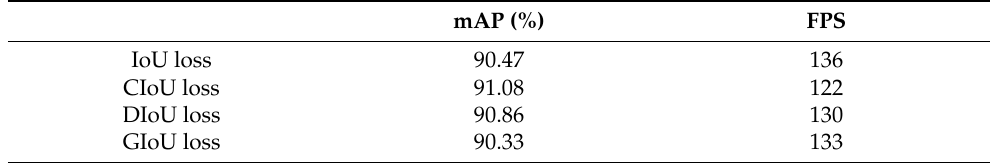
Table 6. Ablation study on loss for regression.